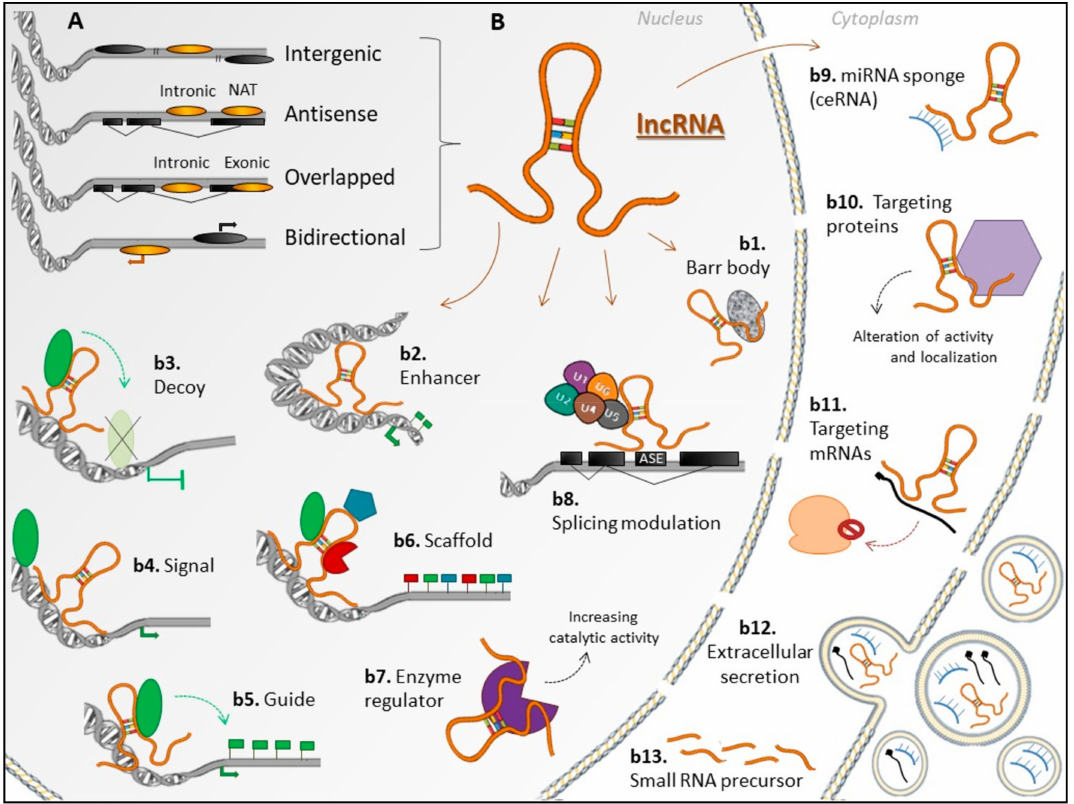
Figure 1. Genomic location relative to protein-coding genes, and regulatory mechanisms of long non-coding RNAs (lncRNAs) in the nucleus, cytoplasm, and extracellular compartments. ( A ) Nomenclature of lncRNA genes (gold ellipses), according to their genomic location relative to the nearest coding gene (black ellipses) and/or to exons of coding genes (black rectangles). ( B )